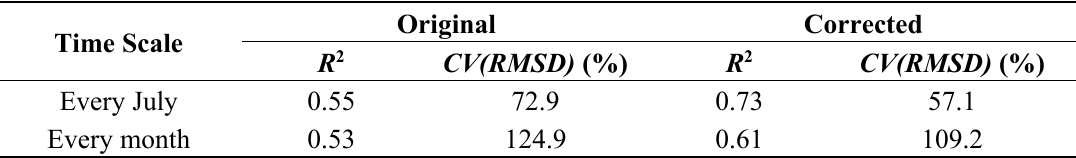
Table 6. Errors of original and corrected monthly rainfall (2001–2012) of 3B43 in Kunlun. Time